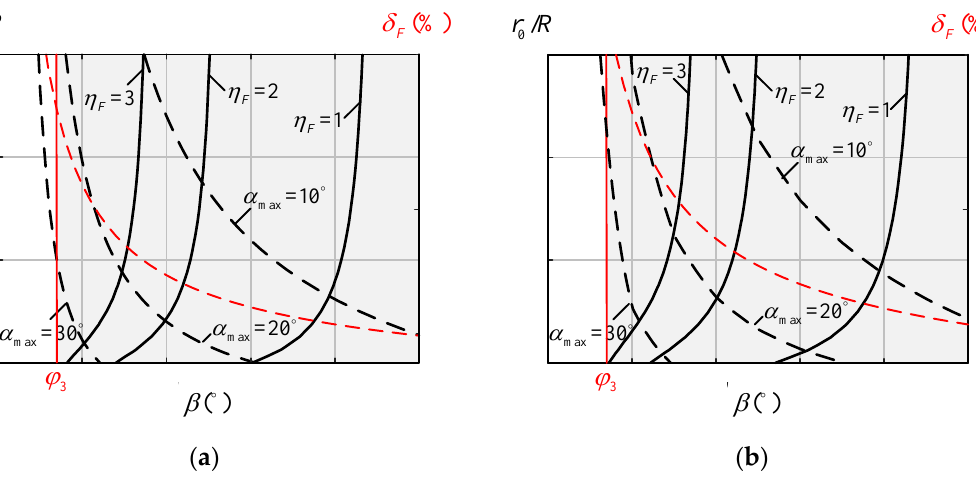
Figure 18. Range of r 0 / R and β corresponding to different α max , η F , and δ F . ( a ) I = 24; ( b ) I = 20. As can be seen from the figure, the ranges of r 0 / R and β are narrowed when η F in- creases and α max decreases for meeting the requirement of higher force transmission rate of the tooth and better force performance of the wave generator. Moreover, by comparing Figure 18a with Figure 18b, the selectable ranges also become narrow as I decreases at the same condition. It is worth noting that the consideration of δ F can further help the selection of β .